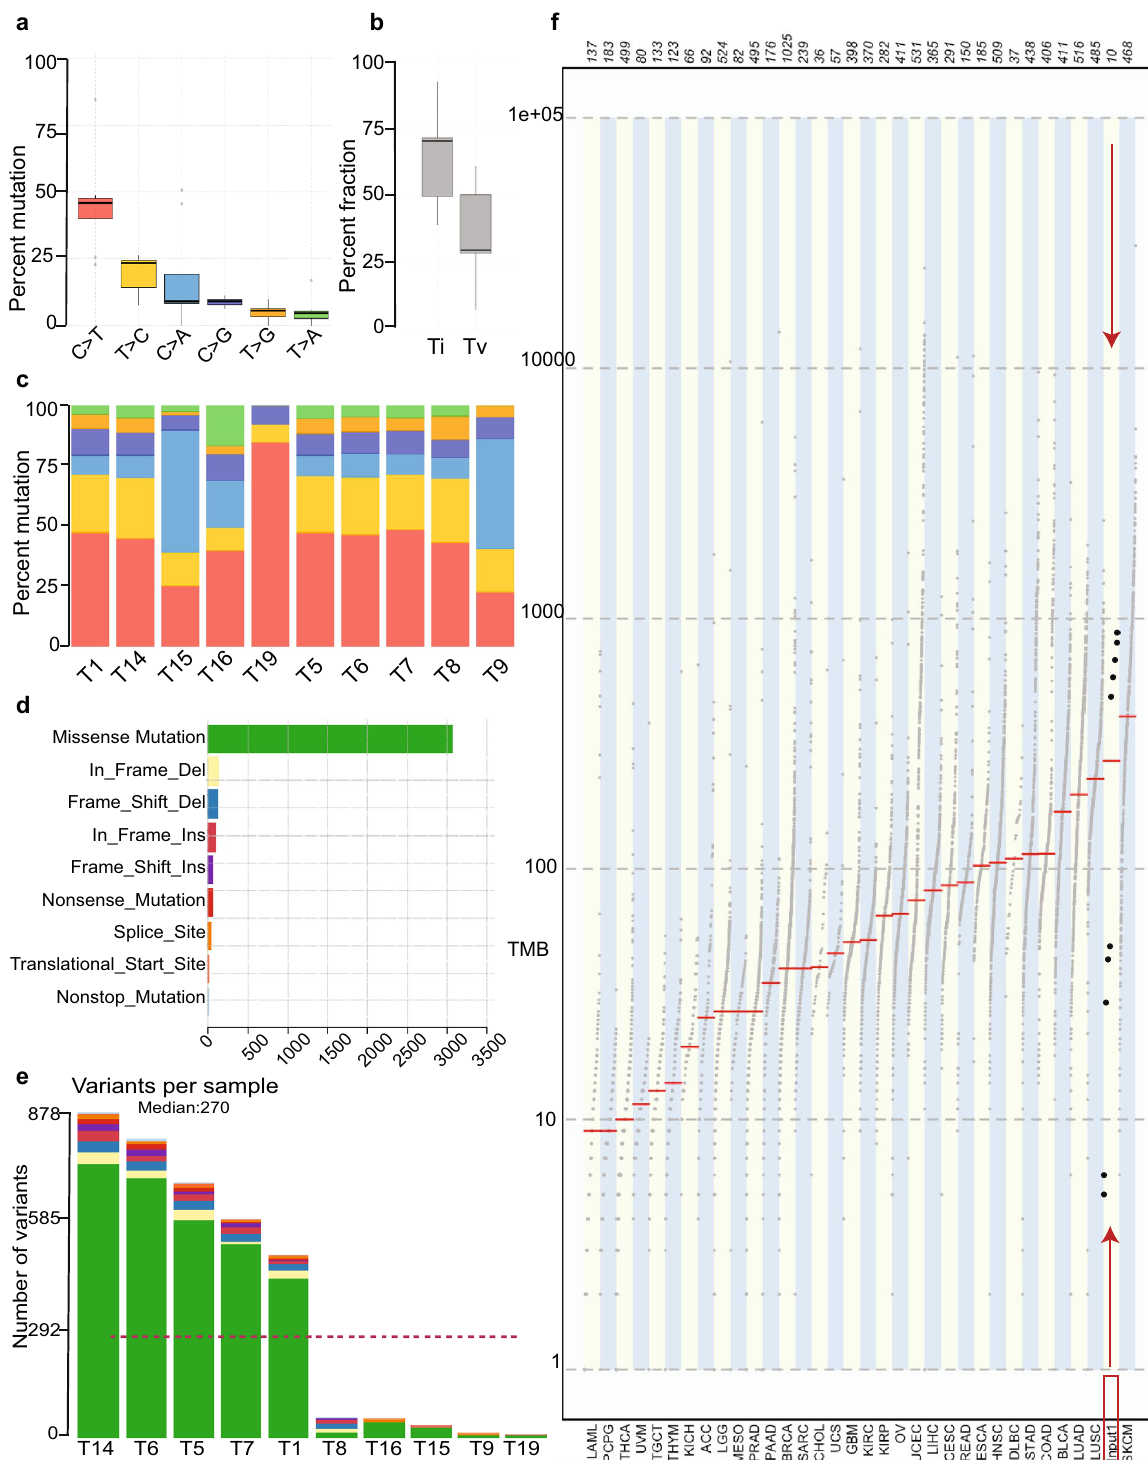
Figure 1. Summary of exome sequencing and tumor mutation burden (TMB). ( a ) Proportion of somatic substitution types in processed and filtered SNVs. ( b ) The ratio of somatic transition to transversion of AA ESCC cohort. ( c ) The proportion of somatic substitution types (C > T, red, T > C, yellow, C > A, blue, C > G, purple, T > G, orange, T > A, green) in each tumor samples. ( d ) The proportion of mutation types in the samples, missense mutations (green), in frame deletions (yellow), frameshift deletions (blue), in frame insertions (brick red), frameshift insertions (purple), nonsense mutations (bright red), changes in the splice sites (orange), and nonstop mutations (light blue). ( e ) Number and types of variants found in each sample. ( f ) The comparison of mutation burden of AA ESCC pilot cohort across TCGA datasets. Our samples are indicated by red rectangle and arrows. Y-axis is the total number of non synonymous mutations found in each tumor